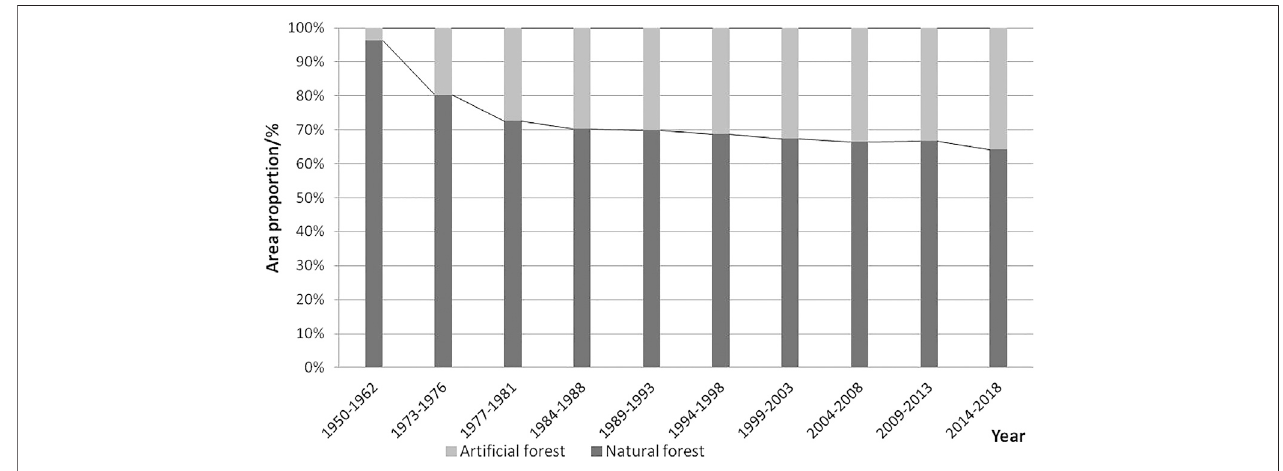
FIGURE 4 | Forest area proportion of arti fi cial forest and natural forest.